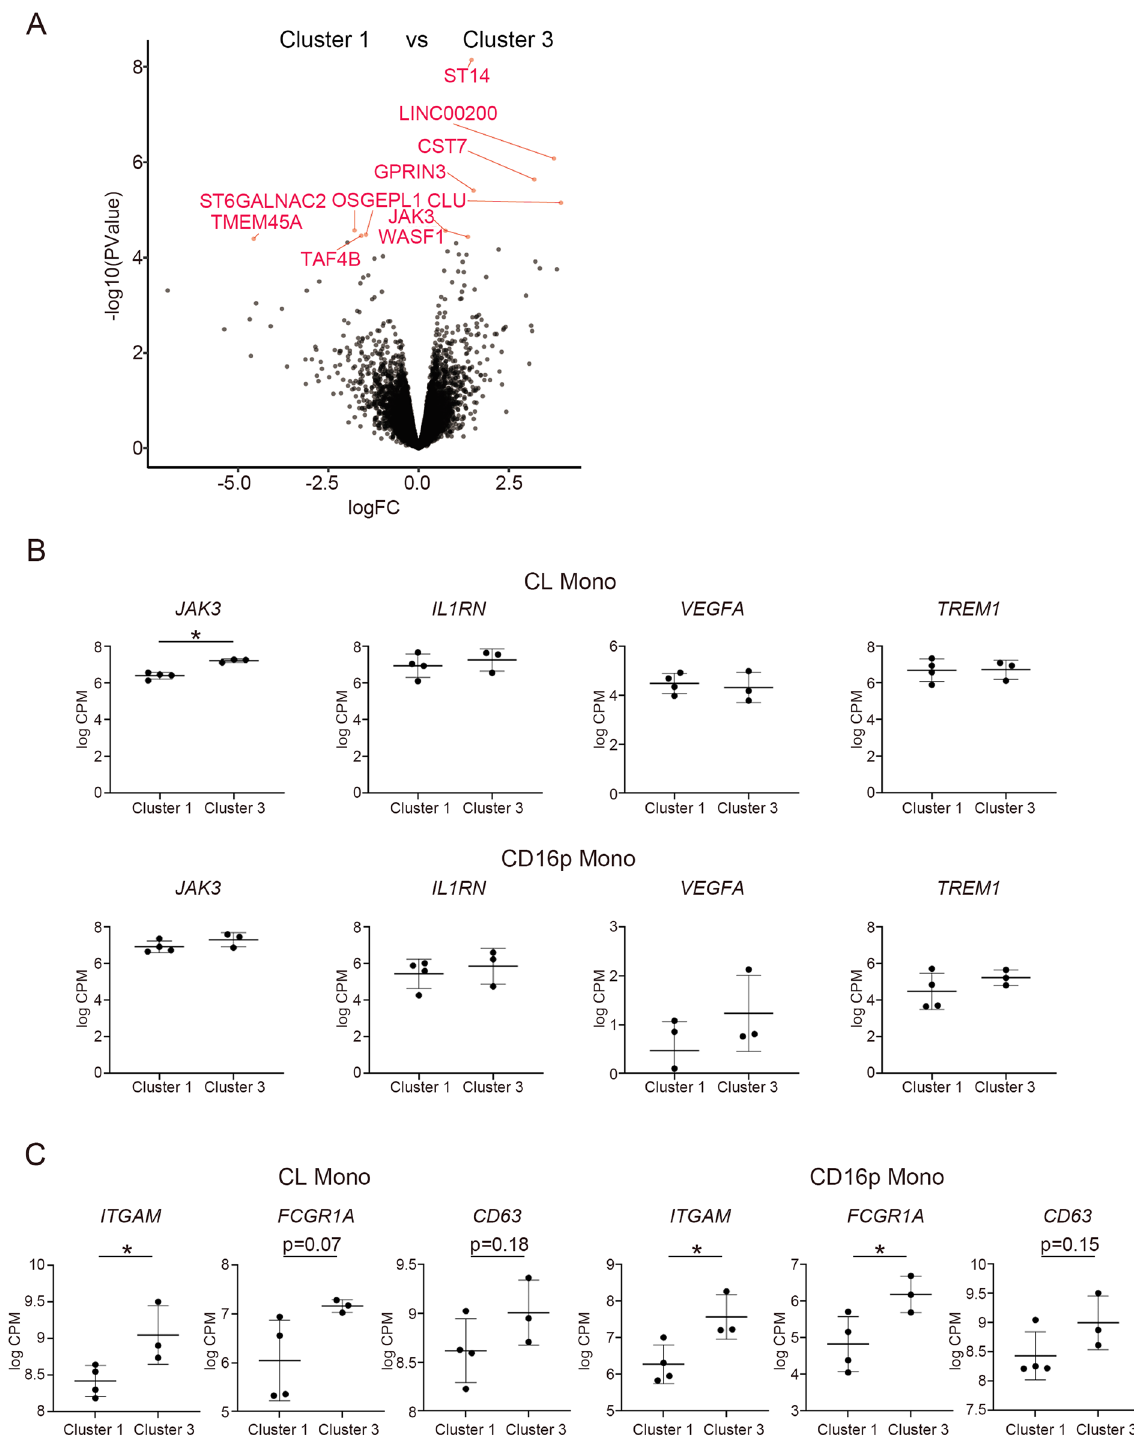
Figure 4. Transcriptomic analysis of monocytes. ( A ) A volcano plot of differential gene expression of classical monocytes. We defined cluster 1 as patients with low serum MPO-DNA complex and CRP, and positive for anti- dsDNA antibody (n = 4), and cluster 3 as patients with high serum MPO-DNA complex and CRP, and negative for anti-dsDNA antibody (n = 3). Upregulated or downregulated genes with FDR < 0.05 are in red. ( B ) JAK3 , IL1RN , VEGF , and TREM1 expression of classical monocytes (top) and CD16 positive monocytes (bottom) was compared between cluster 1 and cluster 3. ( C ) ITGAM , FCGR1A , and CD63 expression of classical monocytes (left) and CD16 positive monocytes (right) was compared between cluster 1 and cluster 3 in the ImmuNexUT database. * P < 0.05; unpaired t-test. Error bars represent mean ± SD. Anti-dsDNA: anti-double stranded DNA antibody; CD16p Mono: CD16-positive monocytes; CL Mono: classical monocytes; CPM: counts per million; CRP; C-reactive protein; FDR: false discovery rate; MPO: